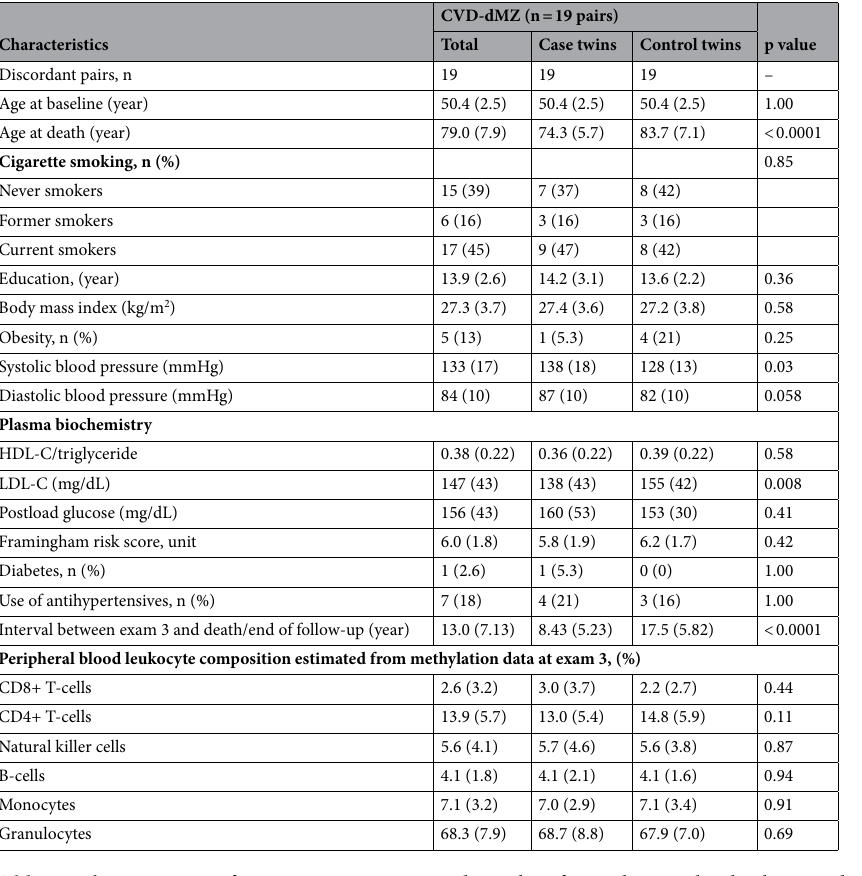
Table 1. Characteristics of monozygotic twin pairs discordant for cardiovascular death CVD-dMZ monozygotic twin pairs discordant for CVD death, HDL-C high-density lipoprotein cholesterol, LDL-C low- density lipoprotein cholesterol. Variables (%) are dichotomous except smoking status. Obesity is defined as body mass index at or greater than 30. Data at baseline are presented as mean (SD) unless otherwise specified. Raw values for continuous variables are presented. All probability values are corrected for pair clustering. Mixed models were used for continuous variables, conditional logistic models for dichotomous variables, and repeated proportional odds model with generalized estimating equation for the 3-level ordinal smoking variable. The conversion of cholesterol from mg/dL to mmol/L is divided by 38.67. The conversion of glucose from mg/dL to mmol/L is divided by